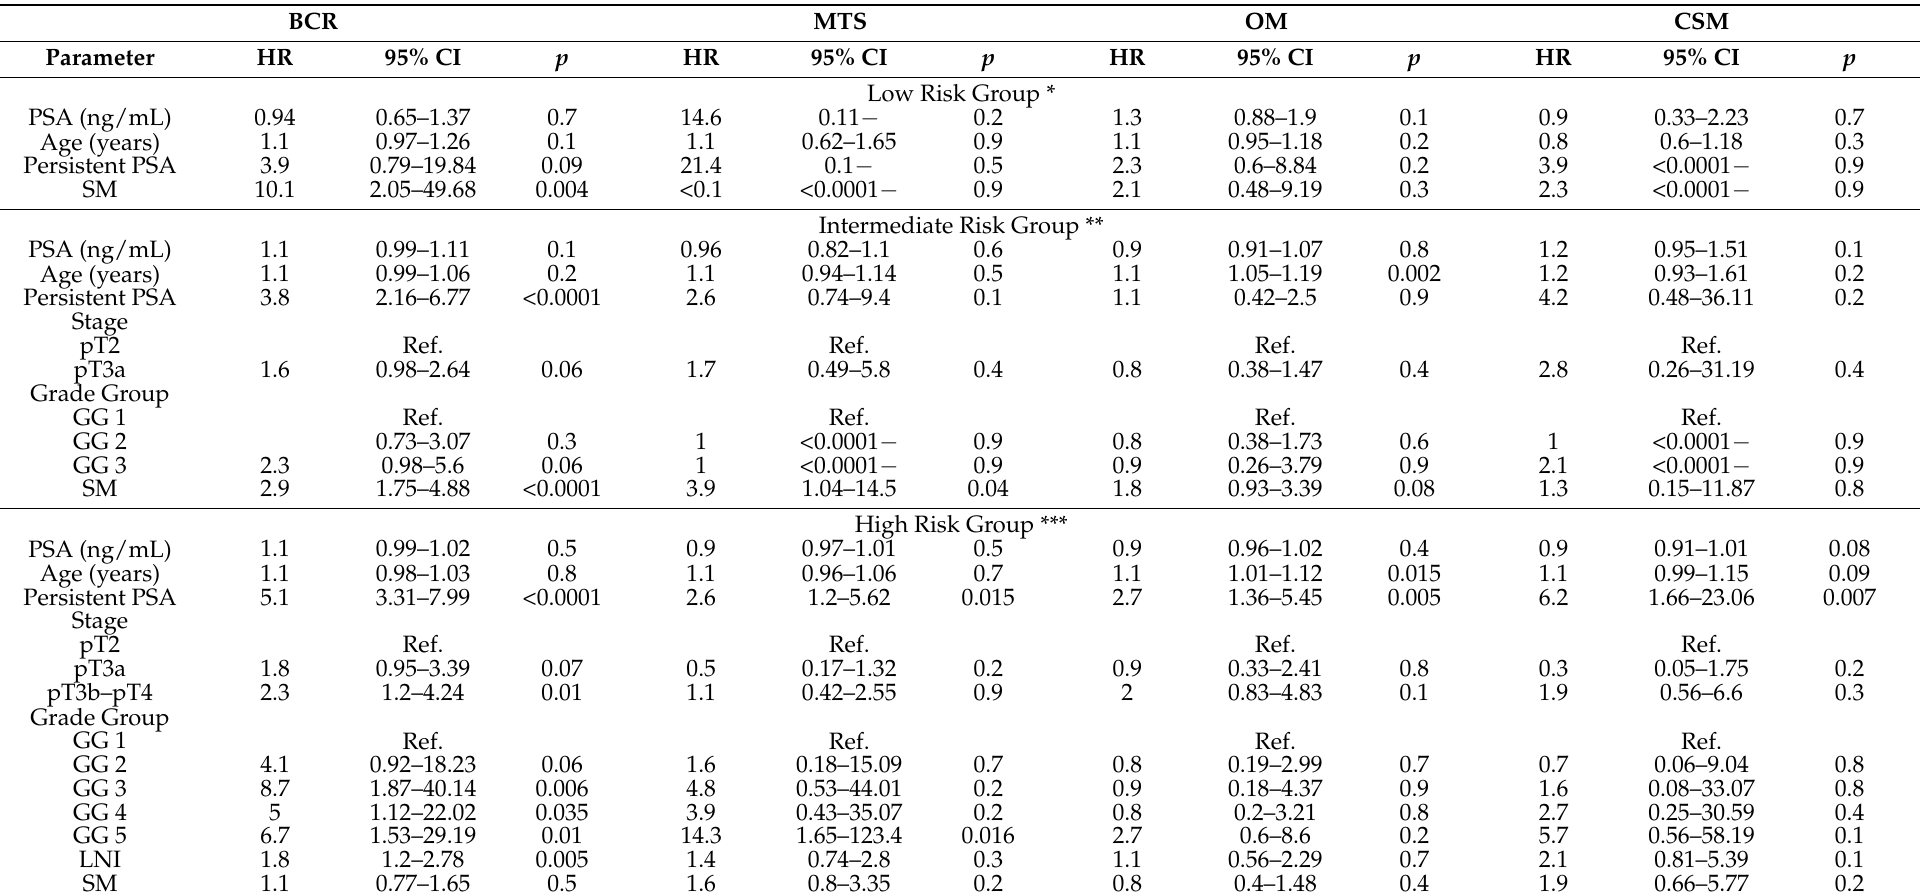
Table 3. Multivariate competing risk analysis of the biochemical recurrence (BCR), developing metastases (MTS), overall mortality (OM) and cancer-specific mortality (CSM) in the low-, intermediate- and high-risk groups. BCR MTS OM CSM Parameter HR